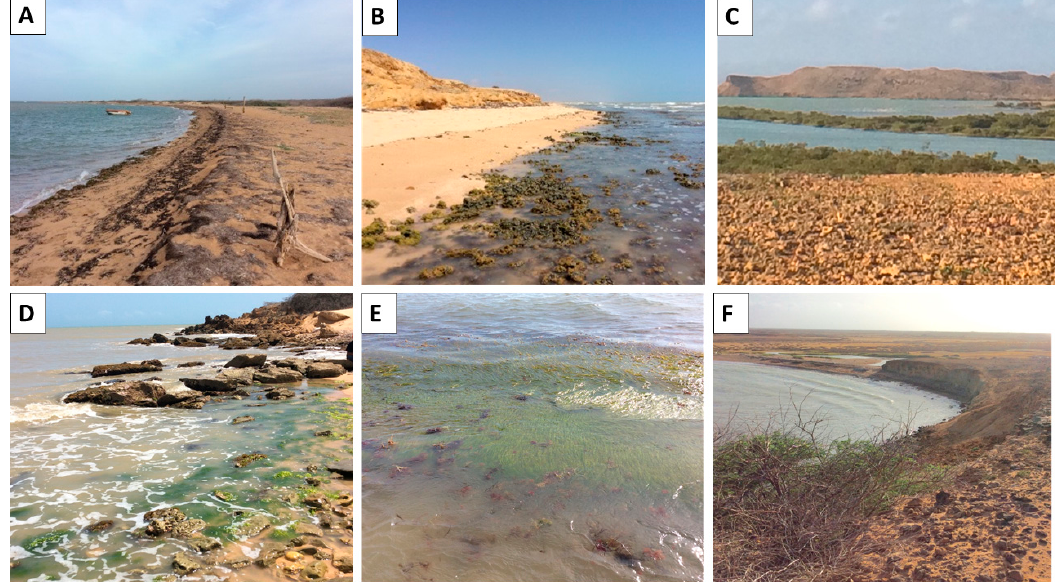
Figure 2. Example biotopes (natural communities in two formations of the nearshore marine regime, in the northeastern Guajira peninsula. Open ocean side formation: ( A ). Unvegetated sandy beach shoreline in open ocean side formation. ( B ). Nearshore shallow macroalgae meadow.; ( D ). Macroalgae vegetated rocky shoreline. ( E ). Nearshore mixed seagrass meadow. ( F ). Rocky cliff shoreline. Marine lagoon formation: ( C ). Mangrove vegetated shoreline.